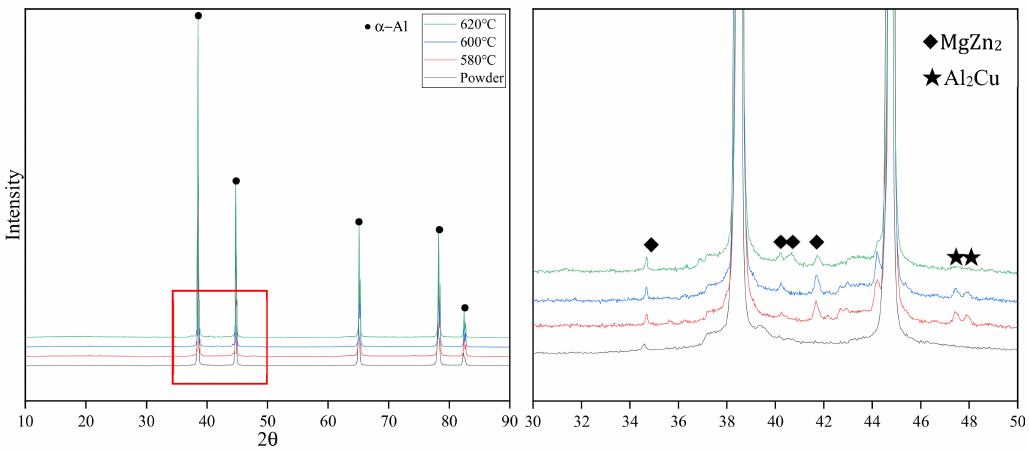
Figure 13. XRD of sintered specimens with a sintering time of 100 min.